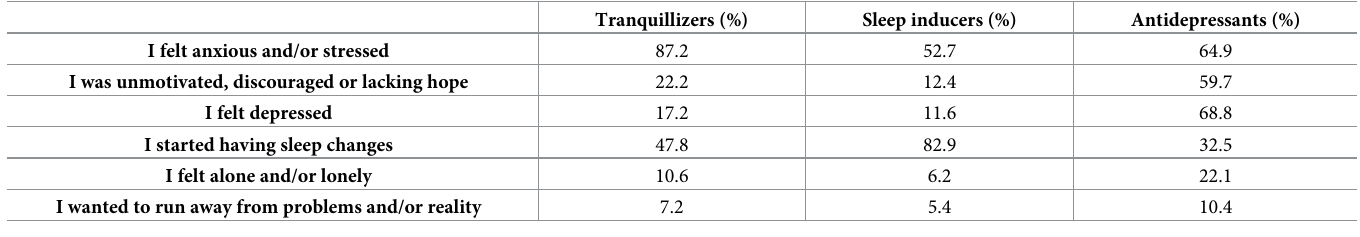
Table 4. Reasons that led to the increase of pharmaceuticals consumption during the COVID-19 pandemic.